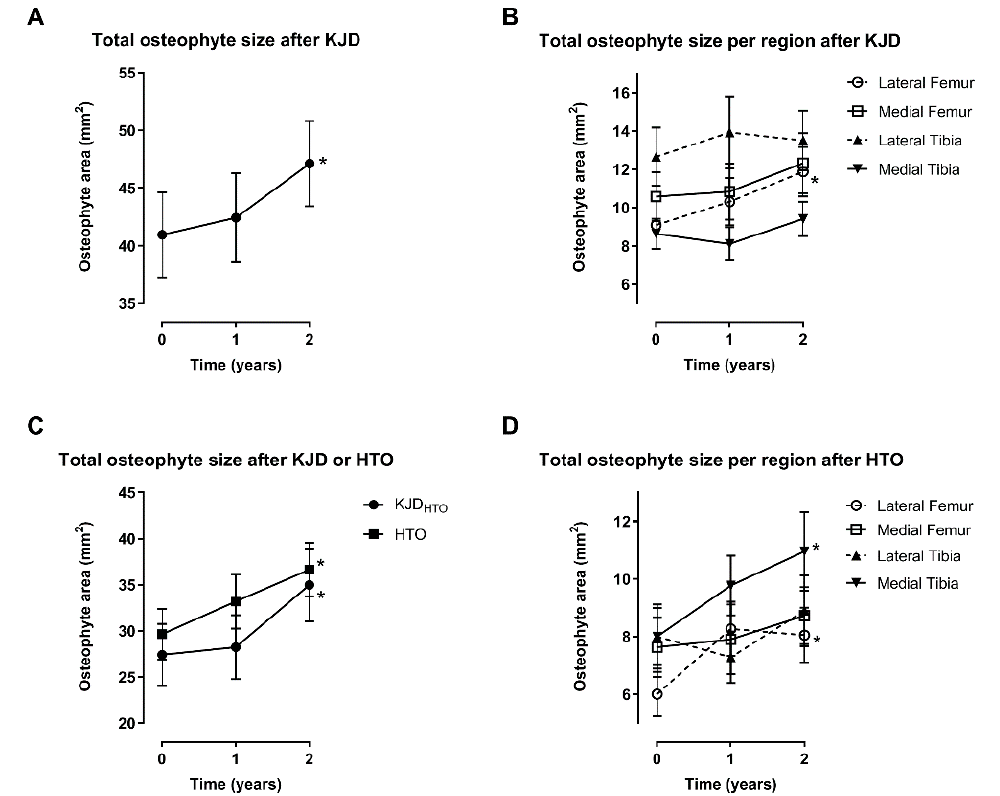
Figure 1. Change in osteophyte size in mm 2 before and one and two years after treatment with knee joint distraction (KJD, n = 58) or high tibial osteotomy (HTO, n = 36). ( A ) The total joint osteophyte area and ( B ) the osteophyte area per compartment after KJD. ( C ) Total joint osteophyte area after KJD or HTO and ( D ) osteophyte area per compartment after HTO. Mean and standard error of the mean (SEM) are shown, * indicates significant changes compared to baseline using repeated measures ANOVA ( p < 0.05).